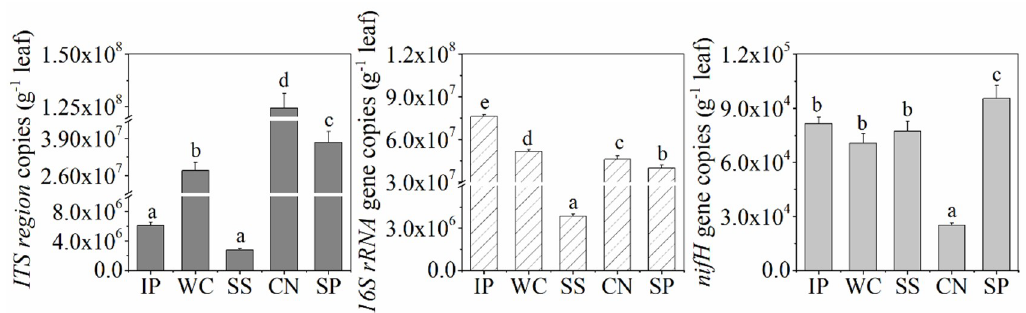
Figure 1. Internal transcribed spacer (ITS) region, 16S rRNA gene and nifH gene copy number as quantified by real-time polymerase chain reaction (PCR) in the phyllosphere samples. Different lowercase letters (a, b, c, d, e) above the columns indicate significant differences among phyllosphere samples at p < 0.05. IP indicates Ipomoea pes-caprae , WC indicates Wedelia chinensis , SS indicates Scaevola sericea, CN indicates Cocos nucifera, SP indicates Sesuvium portulacastrum .